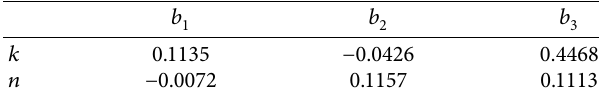
Table 6: Fitting results of the parameters in equation